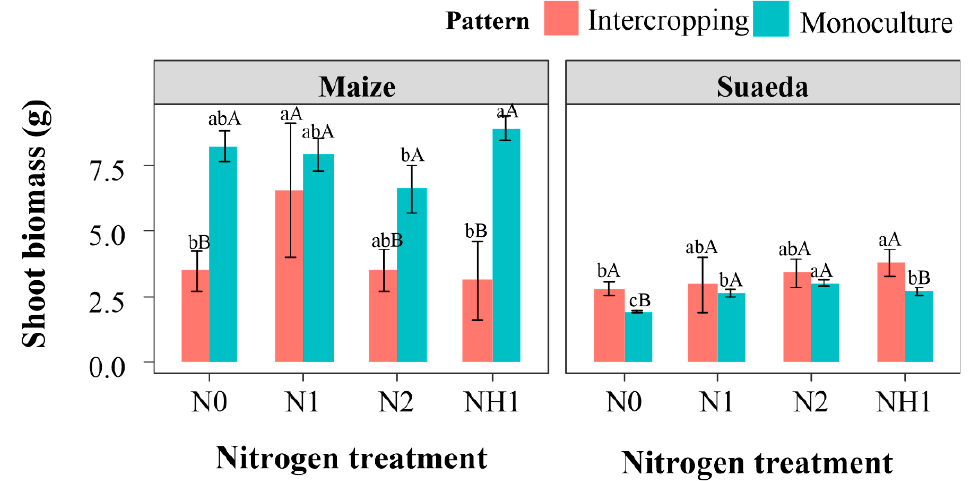
Figure 1. Effect of nitrogen treatment on aboveground biomass of S. salsa and Z. mays L. in the different cropping patterns. Capital letters indicate the significant differences between two cropping patterns. Lower case letters indicate significant differences of four N treatments.